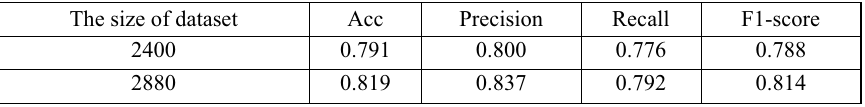
Table 3. Comparison of results when choosing different size of